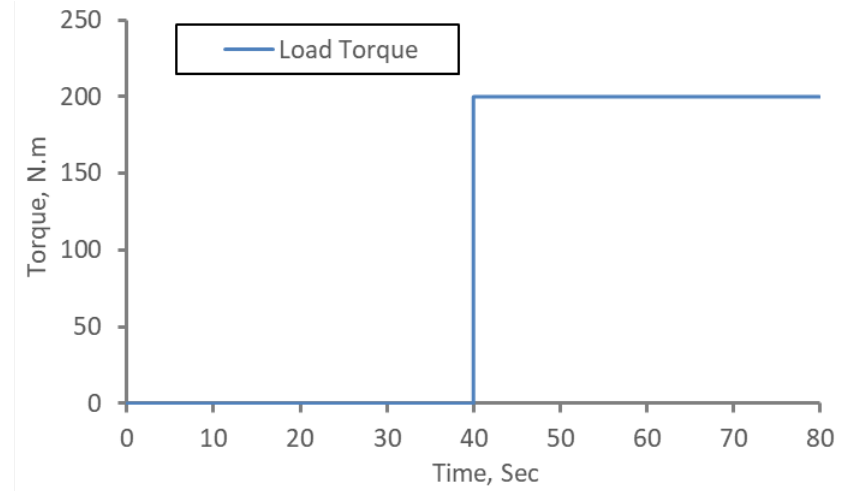
Figure 8. Step input for engine speed controller.